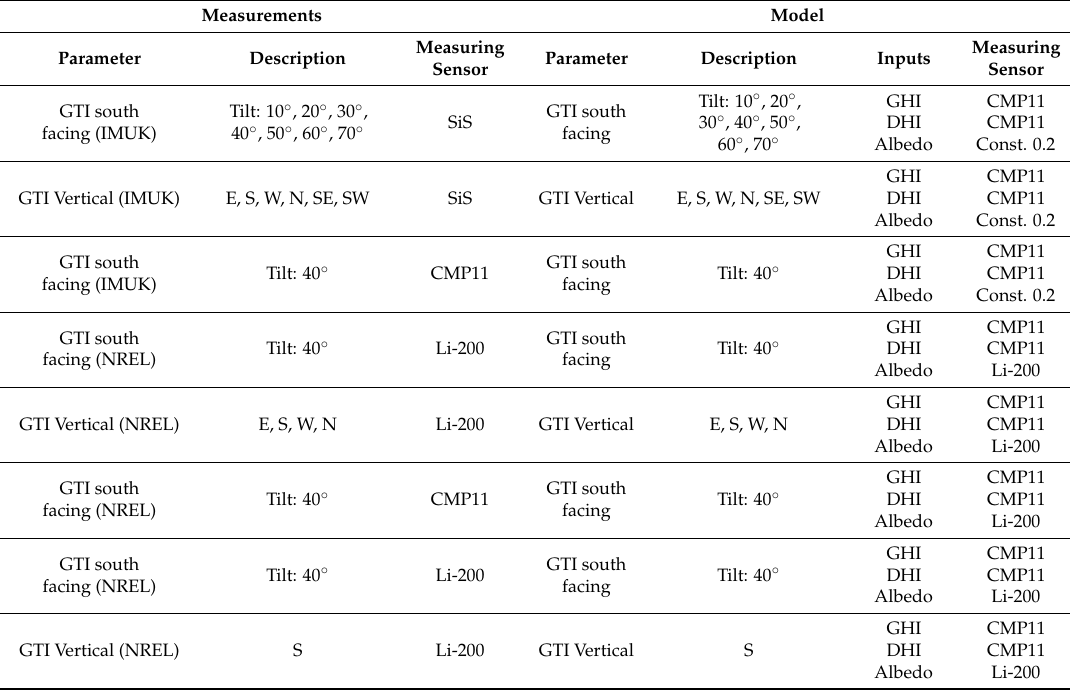
Table 3. Components and data used for comparisons between measurements and